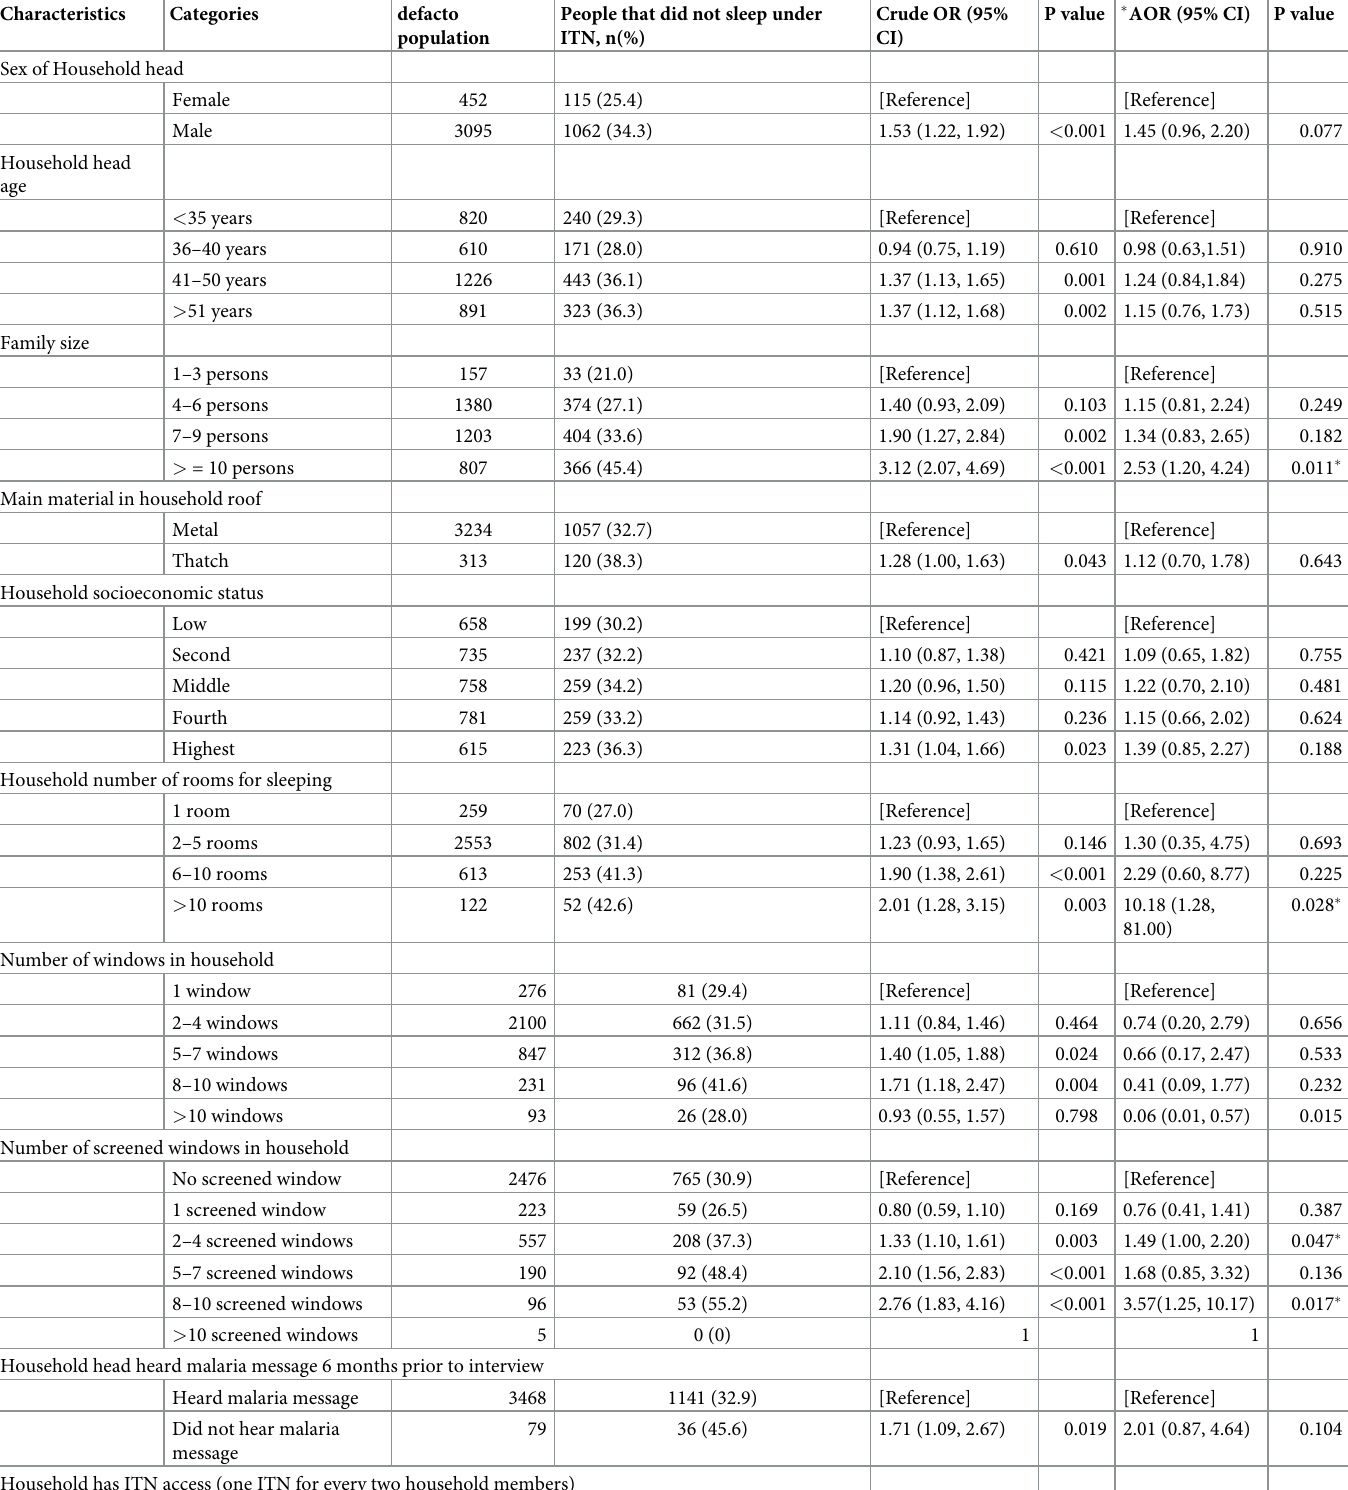
Table 11. Factors associated with non-use of ITN the night preceding the interview among de facto population of households having a minimum of one ITN.